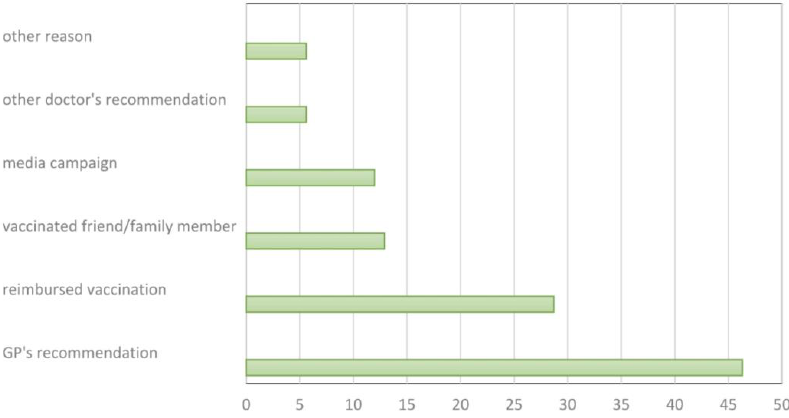
Figure 1. Vaccination history among the surveyed patients by the epidemic season; ( n = 108). Patients vaccinated during the 2018/2019 epidemic season were asked about the rea- sons for being vaccinated. The results are presented in Figure 2. The most commonly re- ported reason was the recommendation of a family physician (46.3%), followed by the vaccination reimbursement (28.7%), recommendation of a vaccinated friend/family mem- ber (12.9%), or media campaign (12.0%). It was a multiple-choice question.